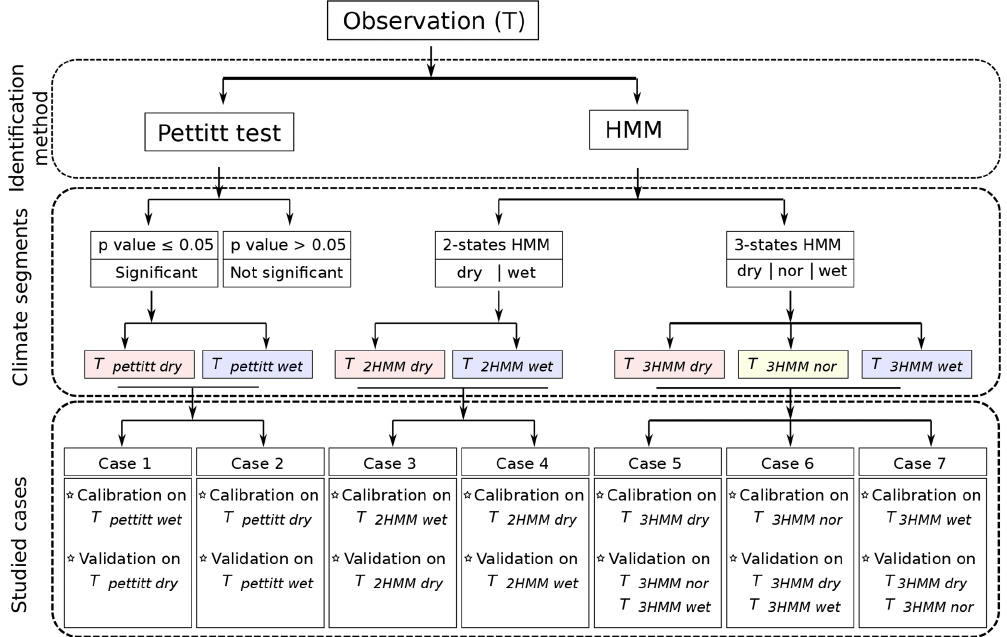
Figure 5. Pettitt’s test and HMM identifications of flow sequences: seven cases for the calibration/validation phase are obtained (note that “nor” represents normal conditions).